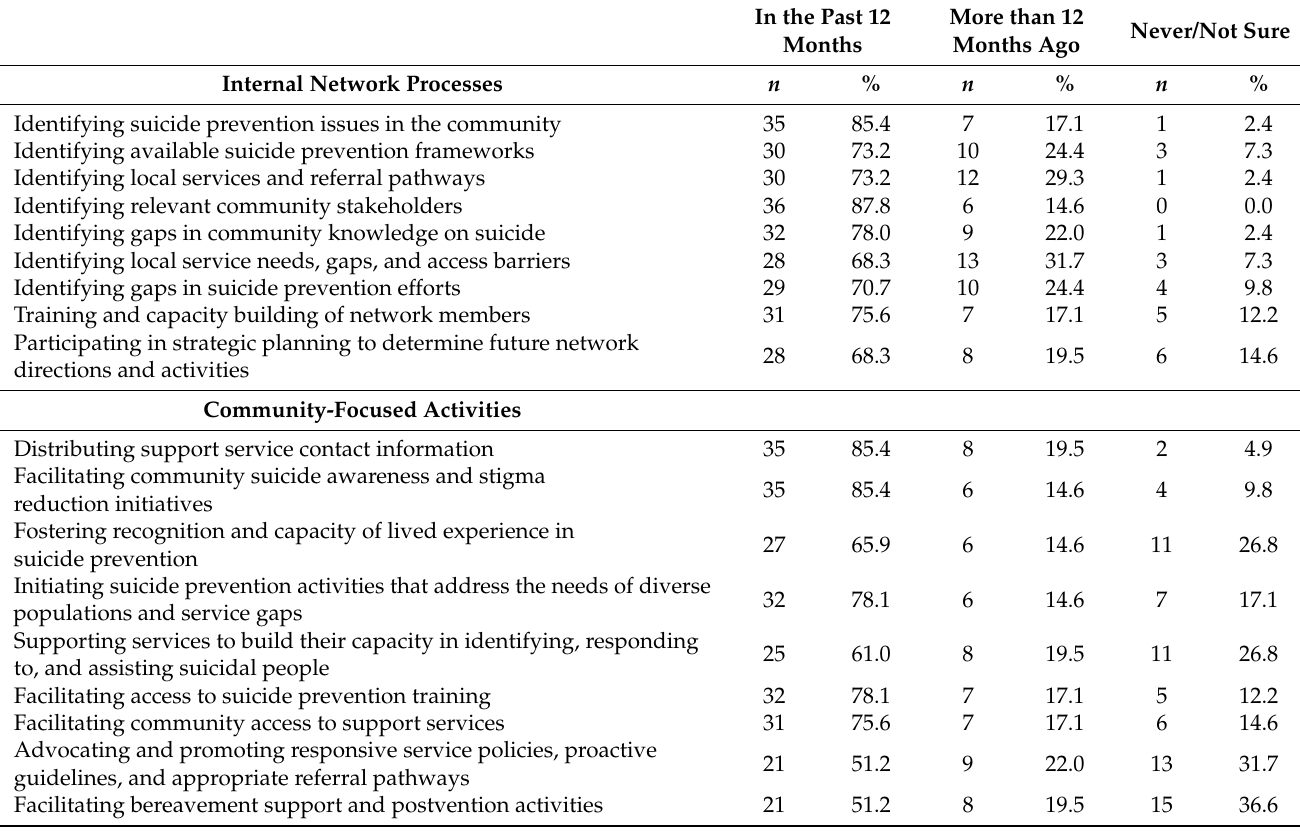
Table 2. Internal network processes and community-focused activities conducted by networks ( N = 41).